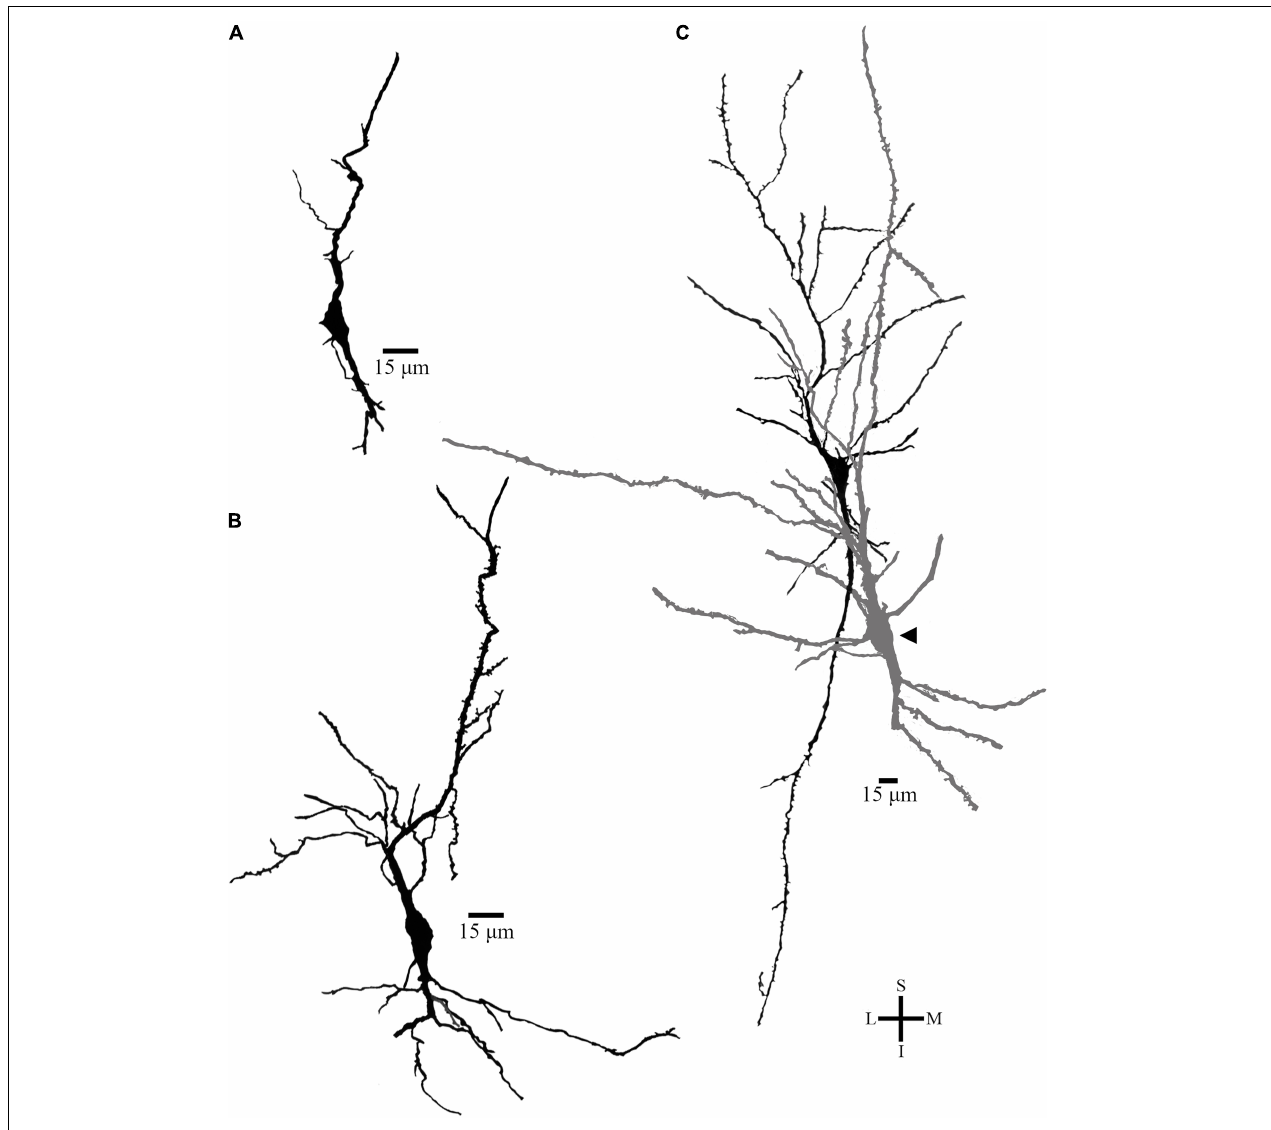
FIGURE 11 | (A,B) Two-dimensional image reconstruction of serial brightfield photomicrographs showing the overall shape of Golgi-impregnated neurons from the pleomorphic layer VI in the human precuneus (central region, 61.1 mm posterior to the midpoint of the anterior commissure, pial surface at the top). Note the fusiform cell body shape, short ascending, and descending primary dendrites with variable ramification and collateral branches. In (C) , a different fusiform cell (in dark) displays two main primary dendritic shafts but also some additional small primary branches that alter the shape of the cell body. The arrow points to a “modified pyramidal neuron” (in gray) according to Braak (1980). Note the scale bar for this figure and compare it to the ones presented for layer V spindle-shaped neurons in this same brain area ( Figures 5–8 ). Image adjustments made with Photoshop CS3 (Adobe Systems, Inc., United